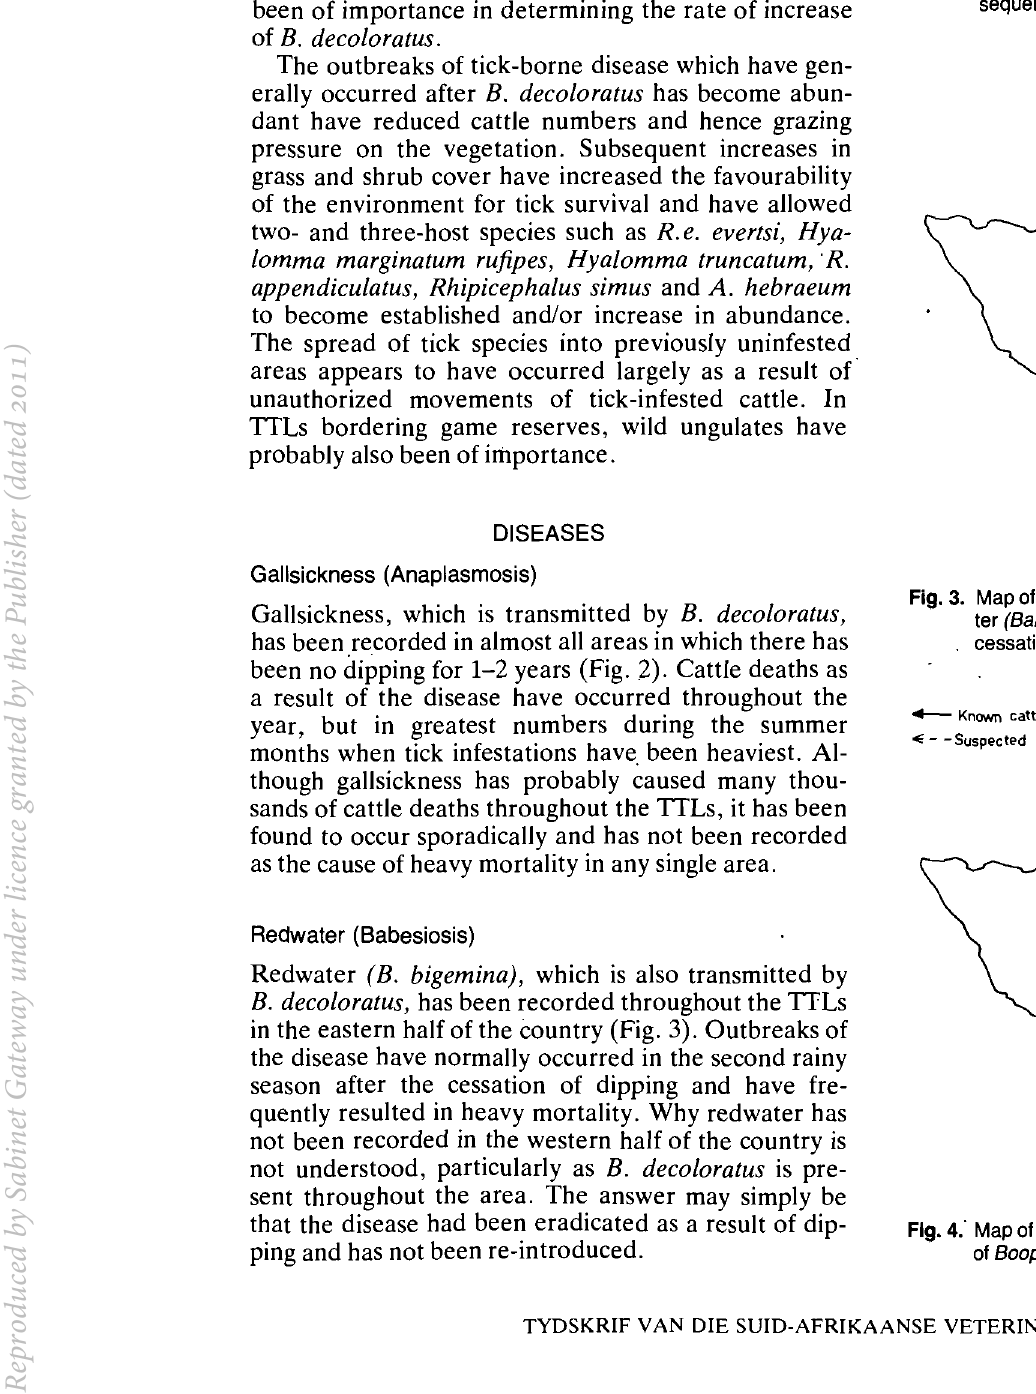
Fig. 2. Map of Zimbabwe Rhodesia indicating areas in which ana plasmosis (Anaplasma marginale) has been recorded sub sequent to the cessation of dipping. ? = unconfirmed.